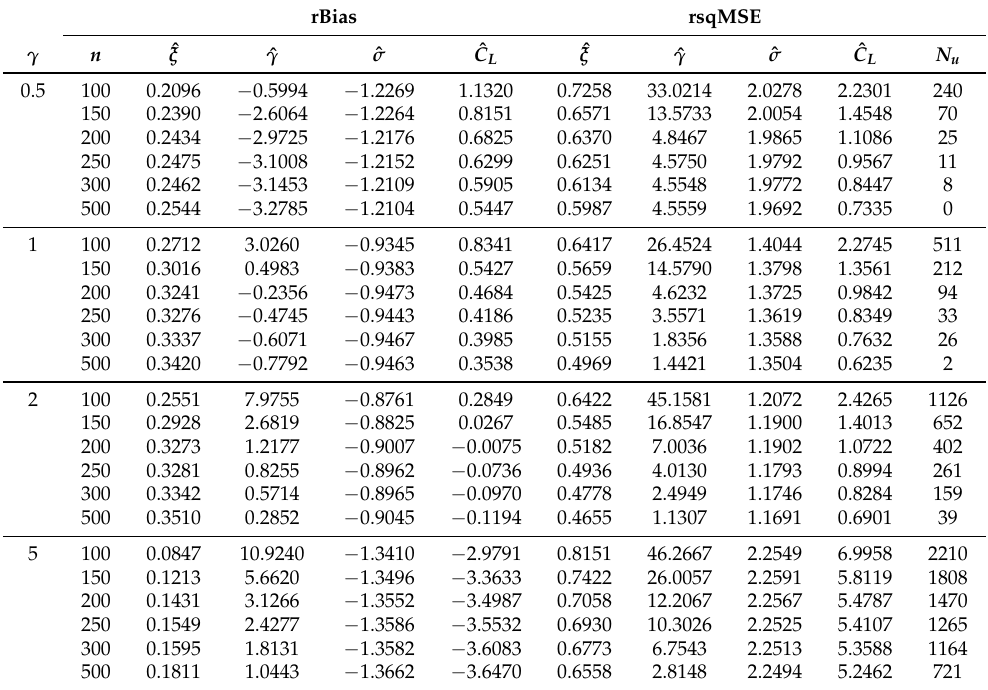
Table 1. The rBias and rsqMSEs of the MLEs of ξ , γ , σ and C L . rBias